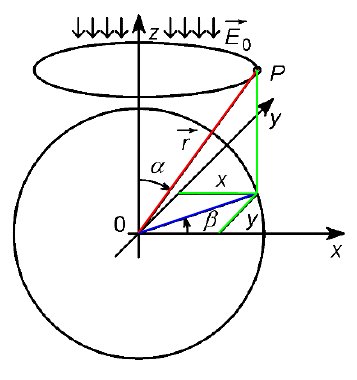
Figure 5 – Effect of a foreign electric field Рис 5 – Воздействие постороннего электрического поля